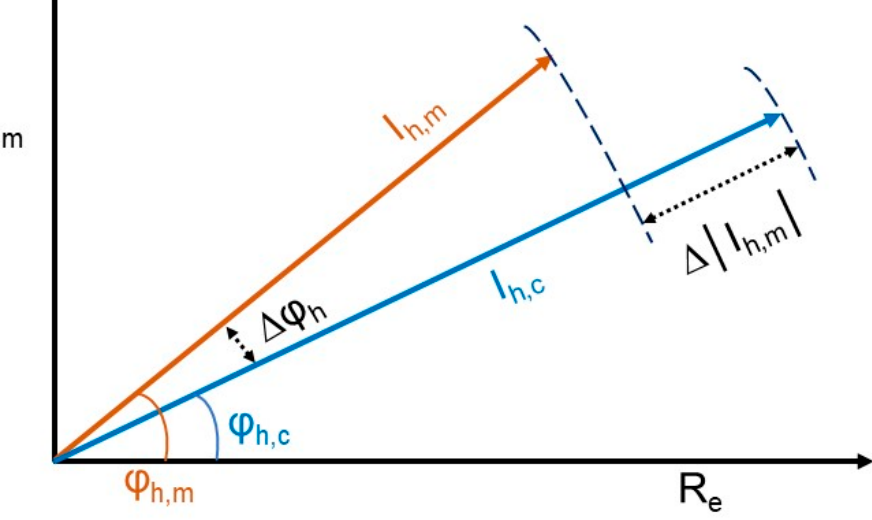
Figure 1. Determining the magnitude and phase angle difference of measured (brown) and calculated (blue) values.